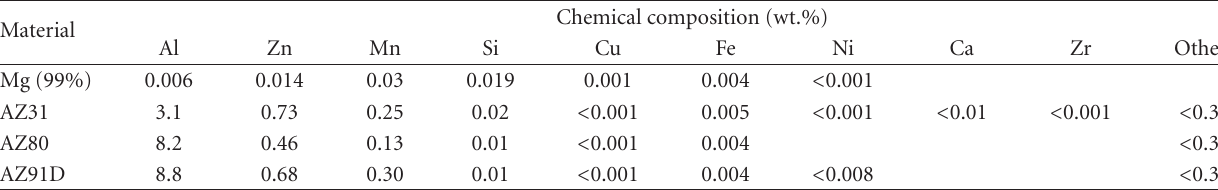
Table 1: Nominal composition of the tested materials.